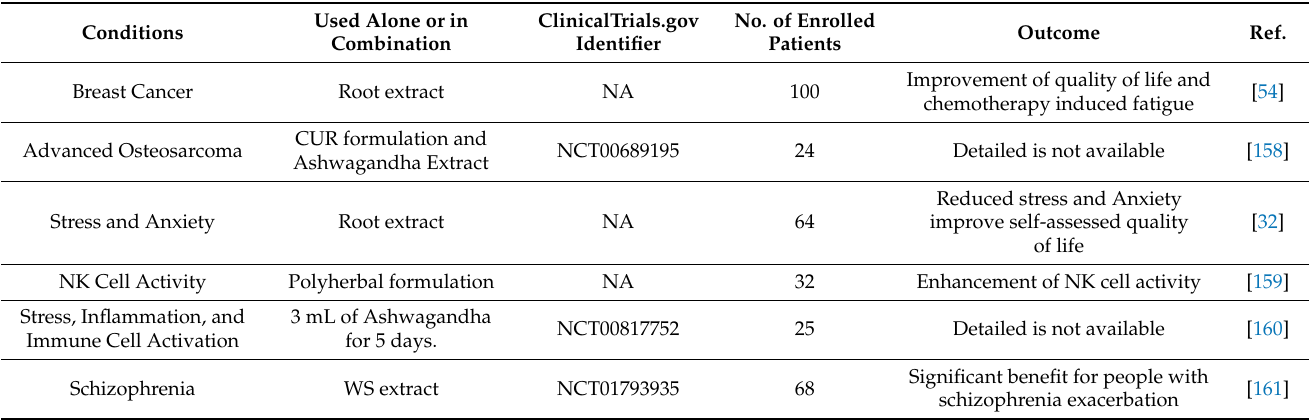
Table 3. Clinical trials involving Withania somnifera ) in Interventional